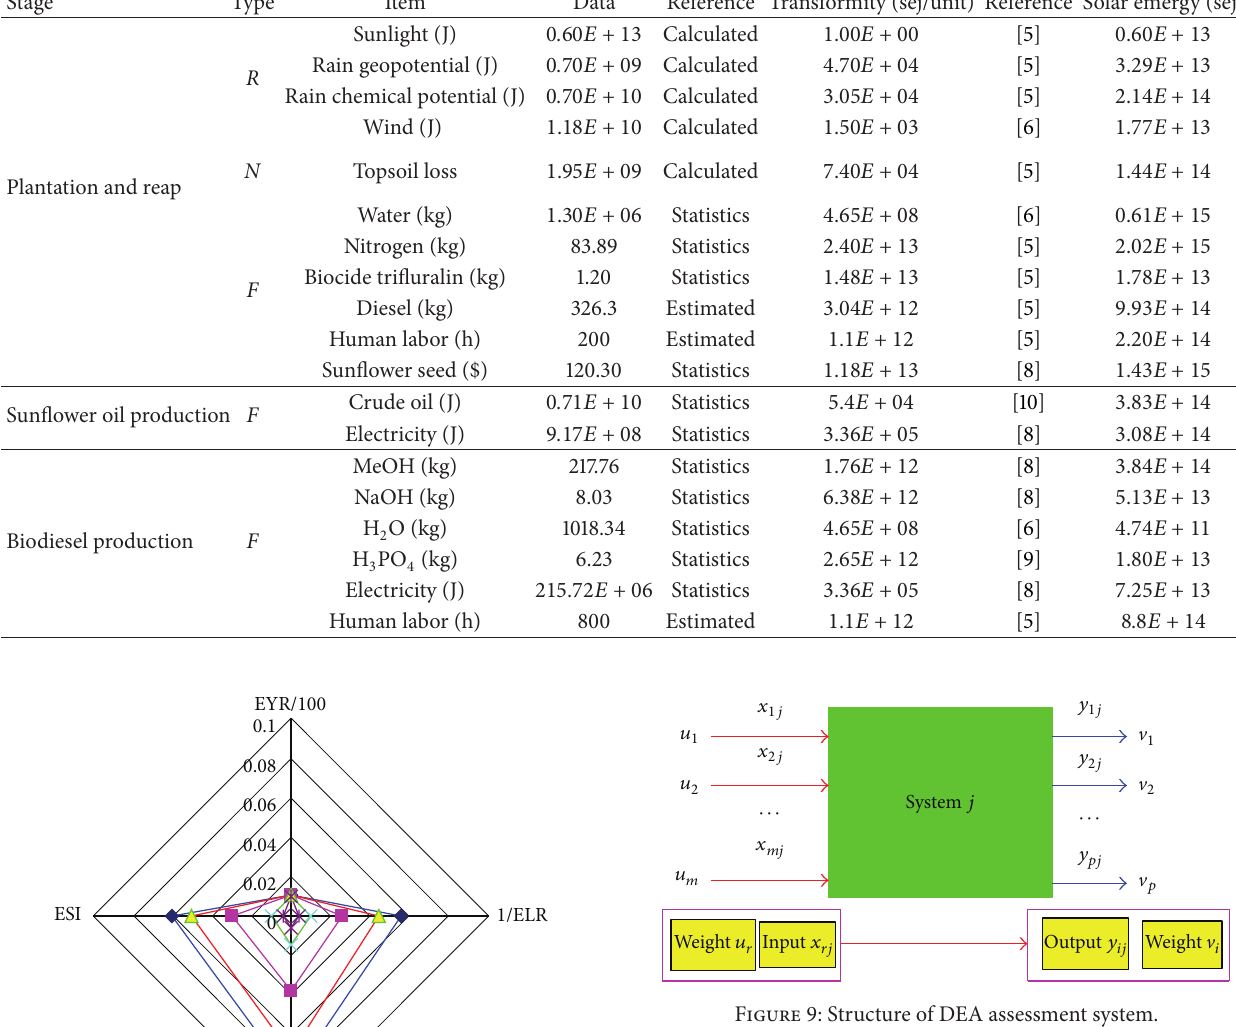
Figure 9: Structure of DEA assessment